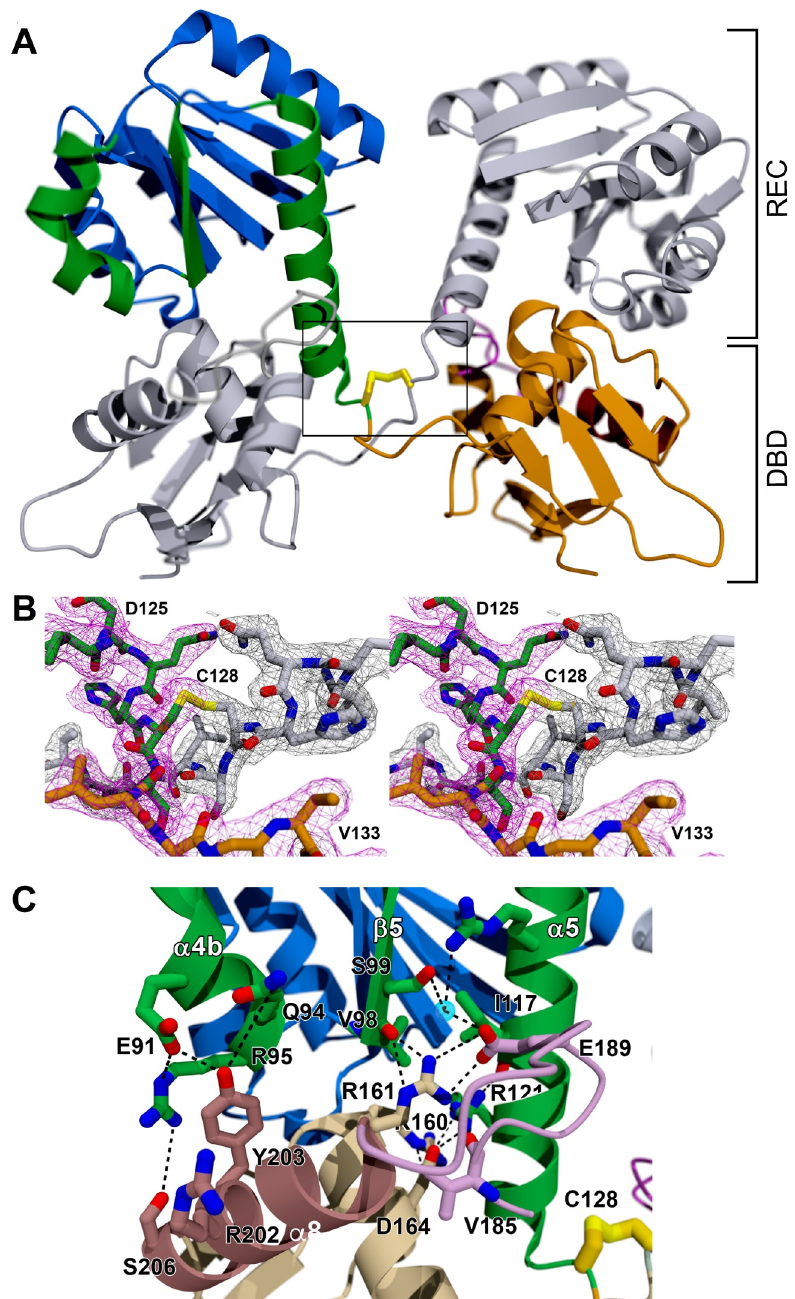
Fig 4. RitR oxidized structure. ( A ) Cartoon representation of the domain-swapped RitR OX structure. One protomer is in color and the other protomer in grey. REC, receiver domain; DBD, DNA-binding domain. ( B ) 2|F o |-|F c | composite omit electron density for the inter-protomer Cys128:Cys128’ disulfide bond and surrounding residues that pins the C-terminal ends of each α 5 helix together. As a consueqence, both DBDs are in close proximity. One protomer is shown in color with a pink density map, and the other protomer is shown in grey with a matching grey density map. ( C ) Image of the interface between the DBD of one protomer of the RitR OX homodimer (bright colors) and the REC domain of the other protomer (muted colors). The interactions are almost identical to those observed for the C128S structure in Fig 3C.